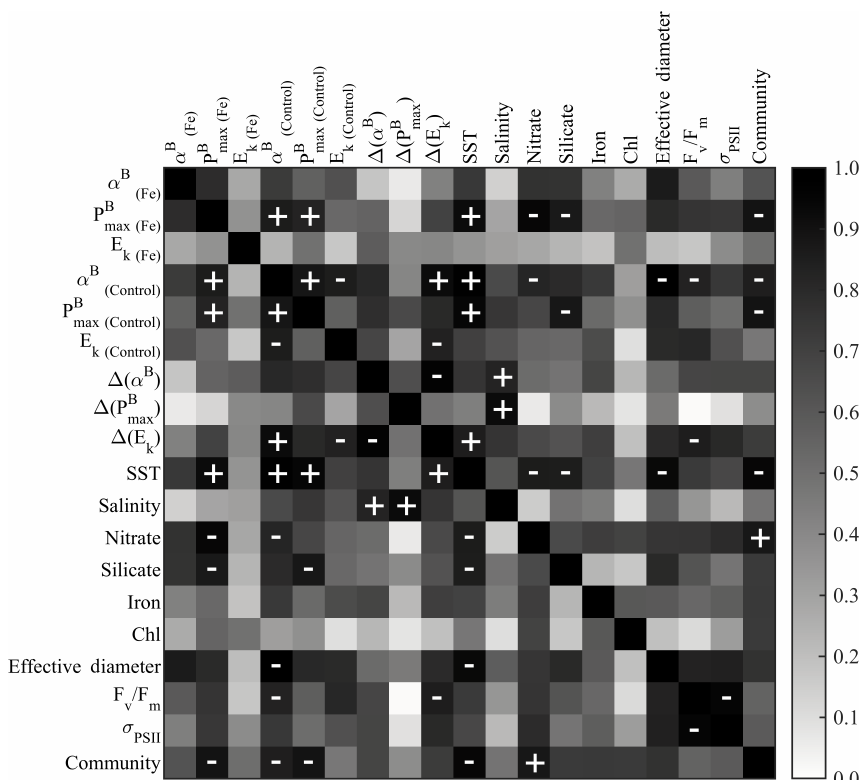
Figure 4. Matrix of Pearson’s linear correlation coefficients between the photosynthetic parameters determined experimentally and in situ variables measured, including α B , P B max and E k from the both Fe and control treatments; the relative differences; sea surface tempera- ture (SST); salinity, nitrate, silicate and dissolved iron concentration; Chl concentration; effective diameter; F v /F m ; σ PSII ; and community composition (ratio of diatoms to haptophytes). The strength of the linear relationship associated between each pair of variables is indicated by the colour of the square, with the negative and positive correlations denoted by “ − ” and “ + ” within all squares where significant ( p <0.05).